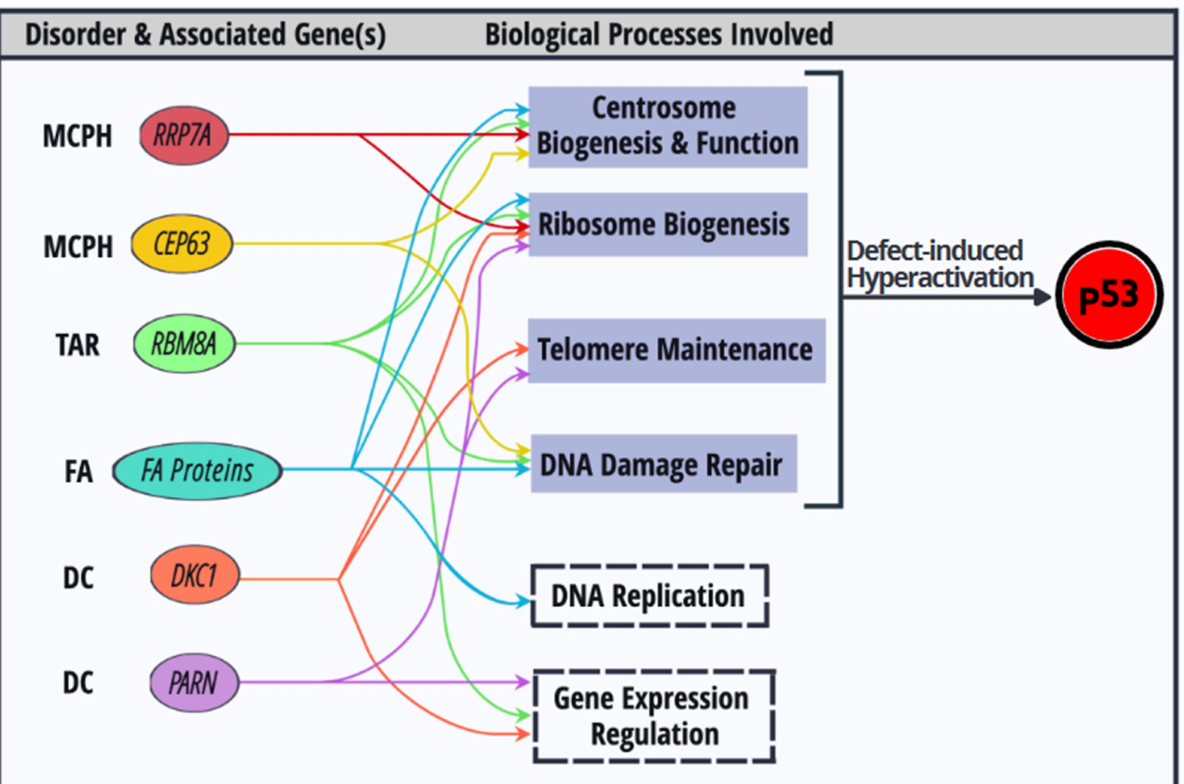
Figure 4. Dysregulation of biological processes that activate p53 and their interconnection. Colored ovals depict pro- tein factors encoded by congenital disorder-associated genes. These factors participate in multiple biological processes. Dysregulation of each biological process (blue grey) activates